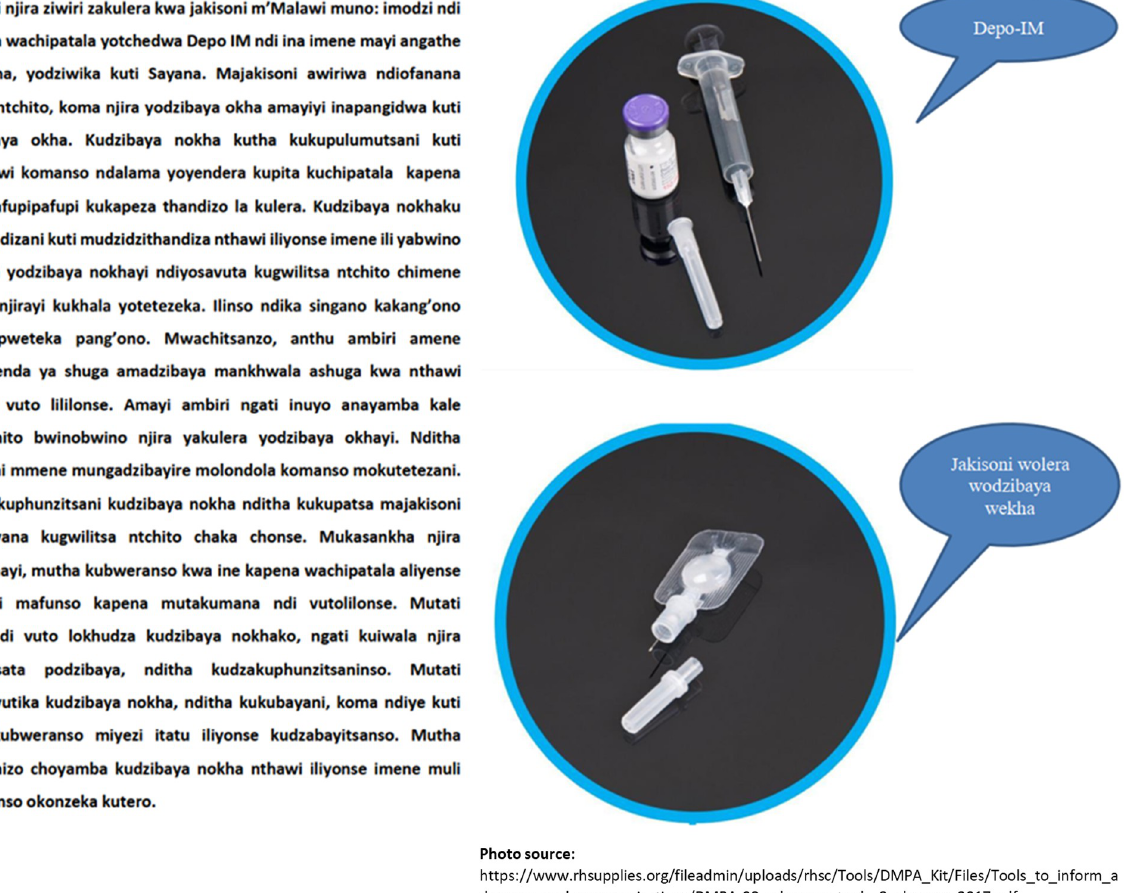
Fig 2. Evidence-based message used in testing phase, in Chichewa, with pictures of the two injectable options.